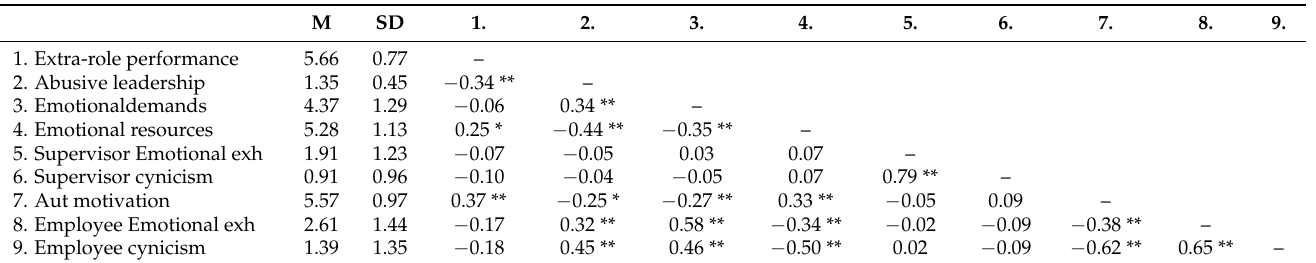
Table 1. Descriptive and correlational